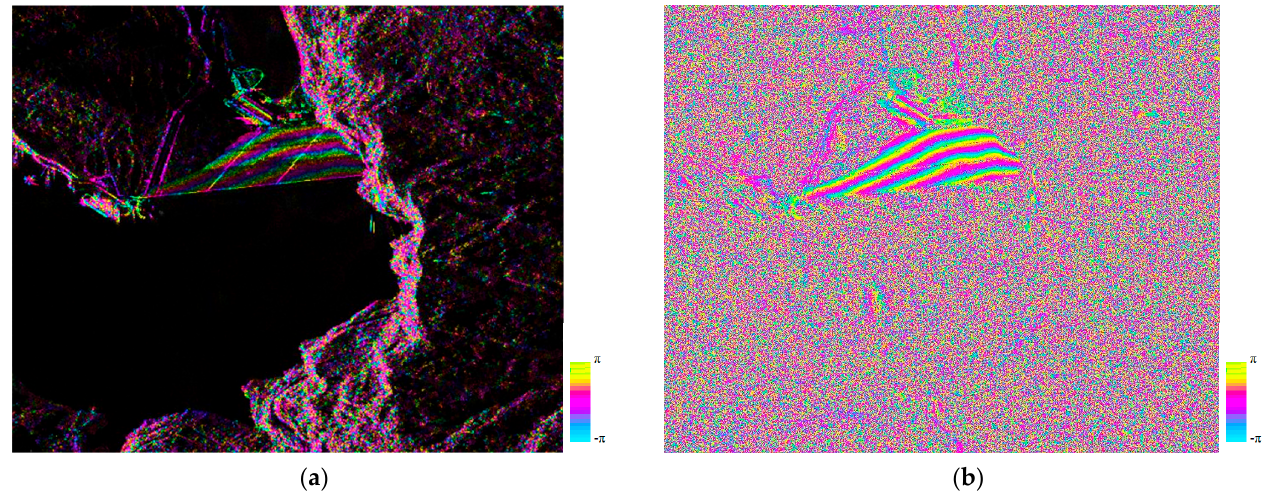
Figure 7. A zoom − in map of the interferogram (the red rectangle box area shown in Figure 6) be- tween the slave 20,160,810 SLC and master 20,160,725 SLC; the fringes can be observed over the dam area. ( a ) The interferogram phase after flattening and filtering was laid out on the amplitude of the interferogram complex data. ( b ) The interferogram phase after flattening and filtering in the same area.